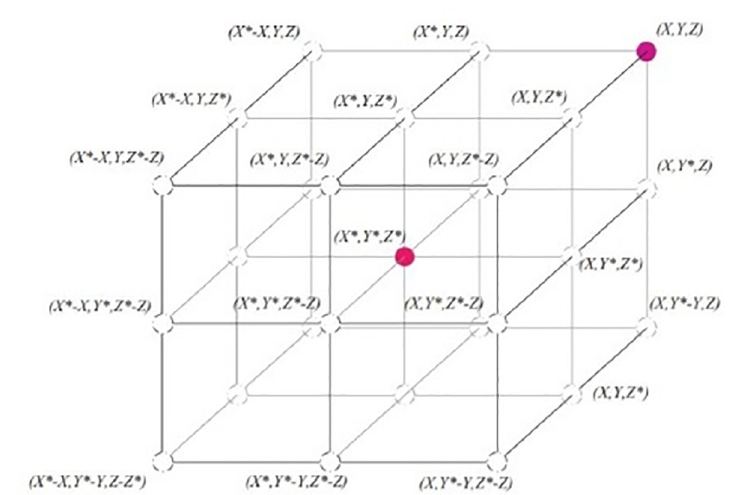
Fig 4. Position vectors along with possible next locations in three dimensions (3D)